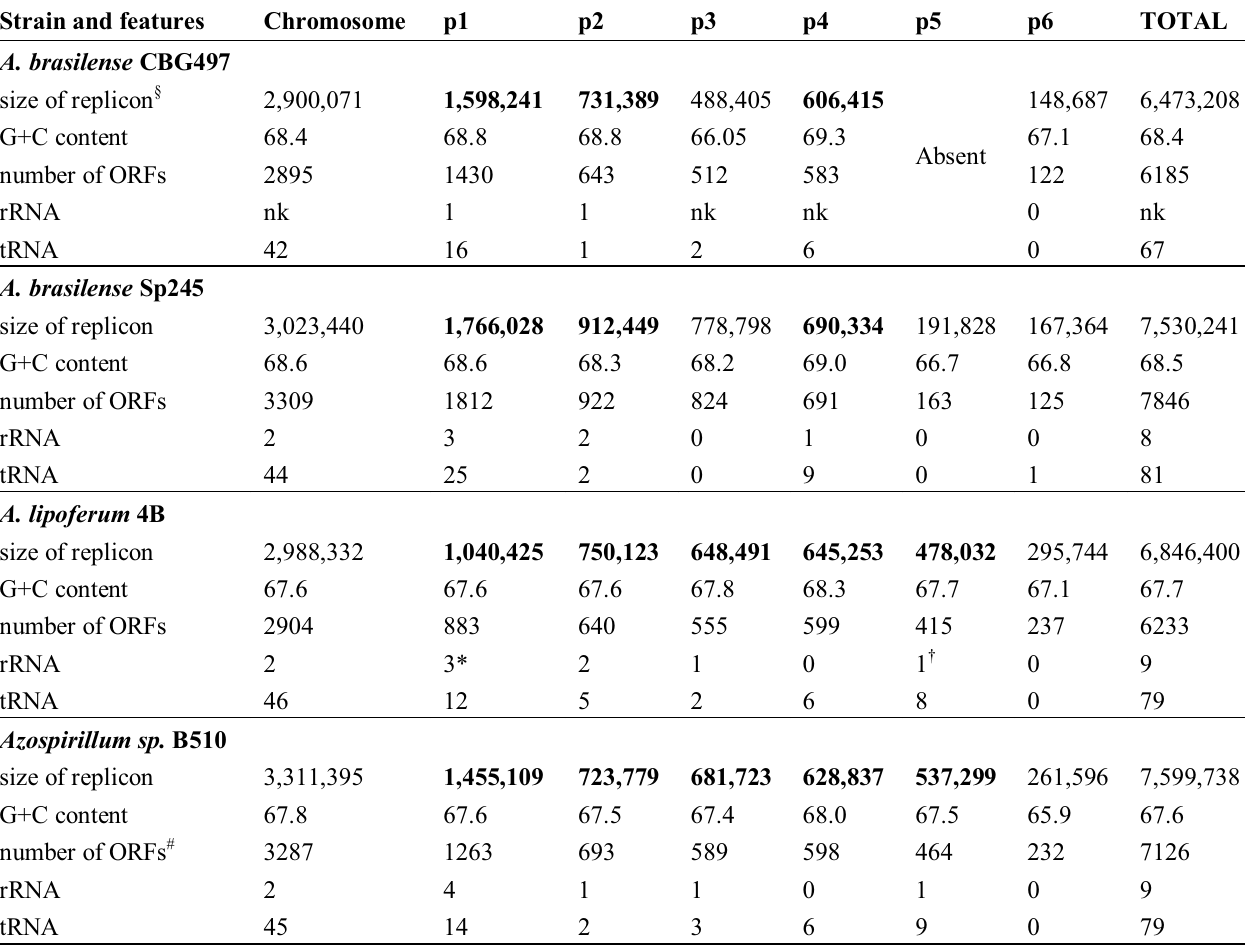
Table 1. Genomic features of Azospirillum strains used in this